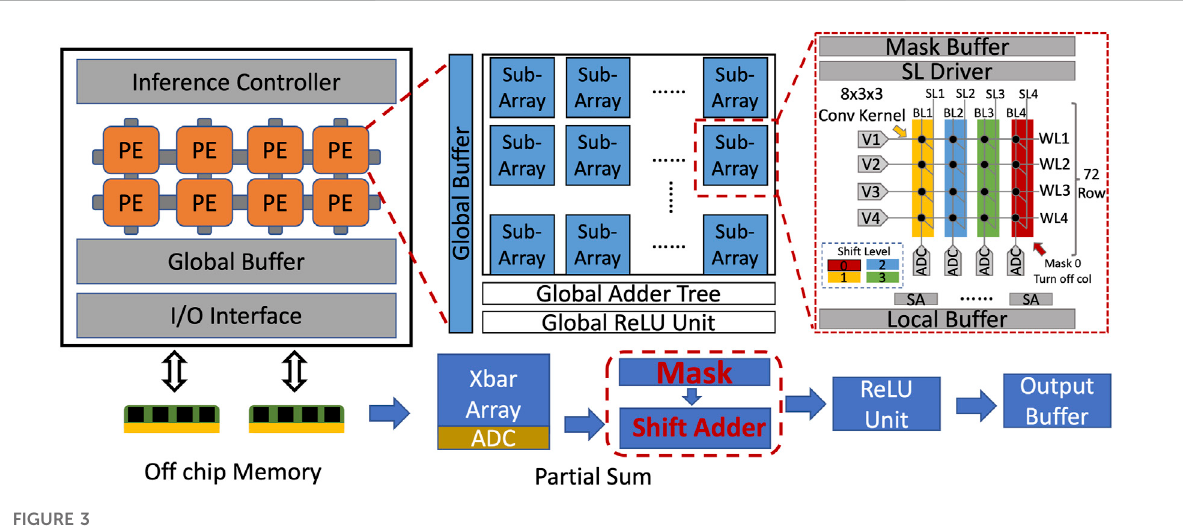
FIGURE 3 Hardware structure and